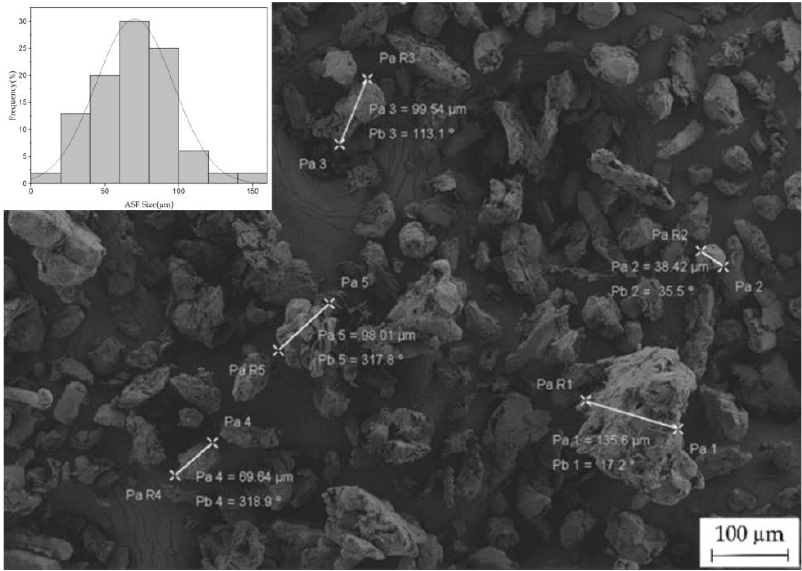
Figure 1. Visual aspect of almond shell flour particles obtained by field emission scanning electron microscopy (FESEM) at 100× and a histogram of their size distribution.